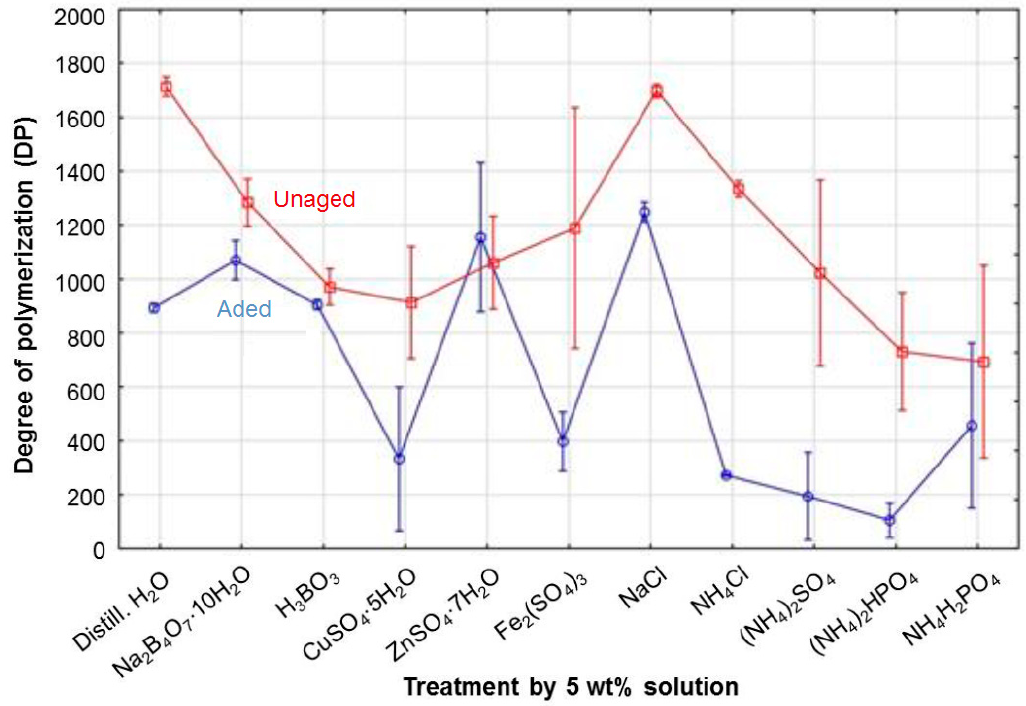
Figure 2. Influence of solution*aging on the degree of polymerization in cellulose.